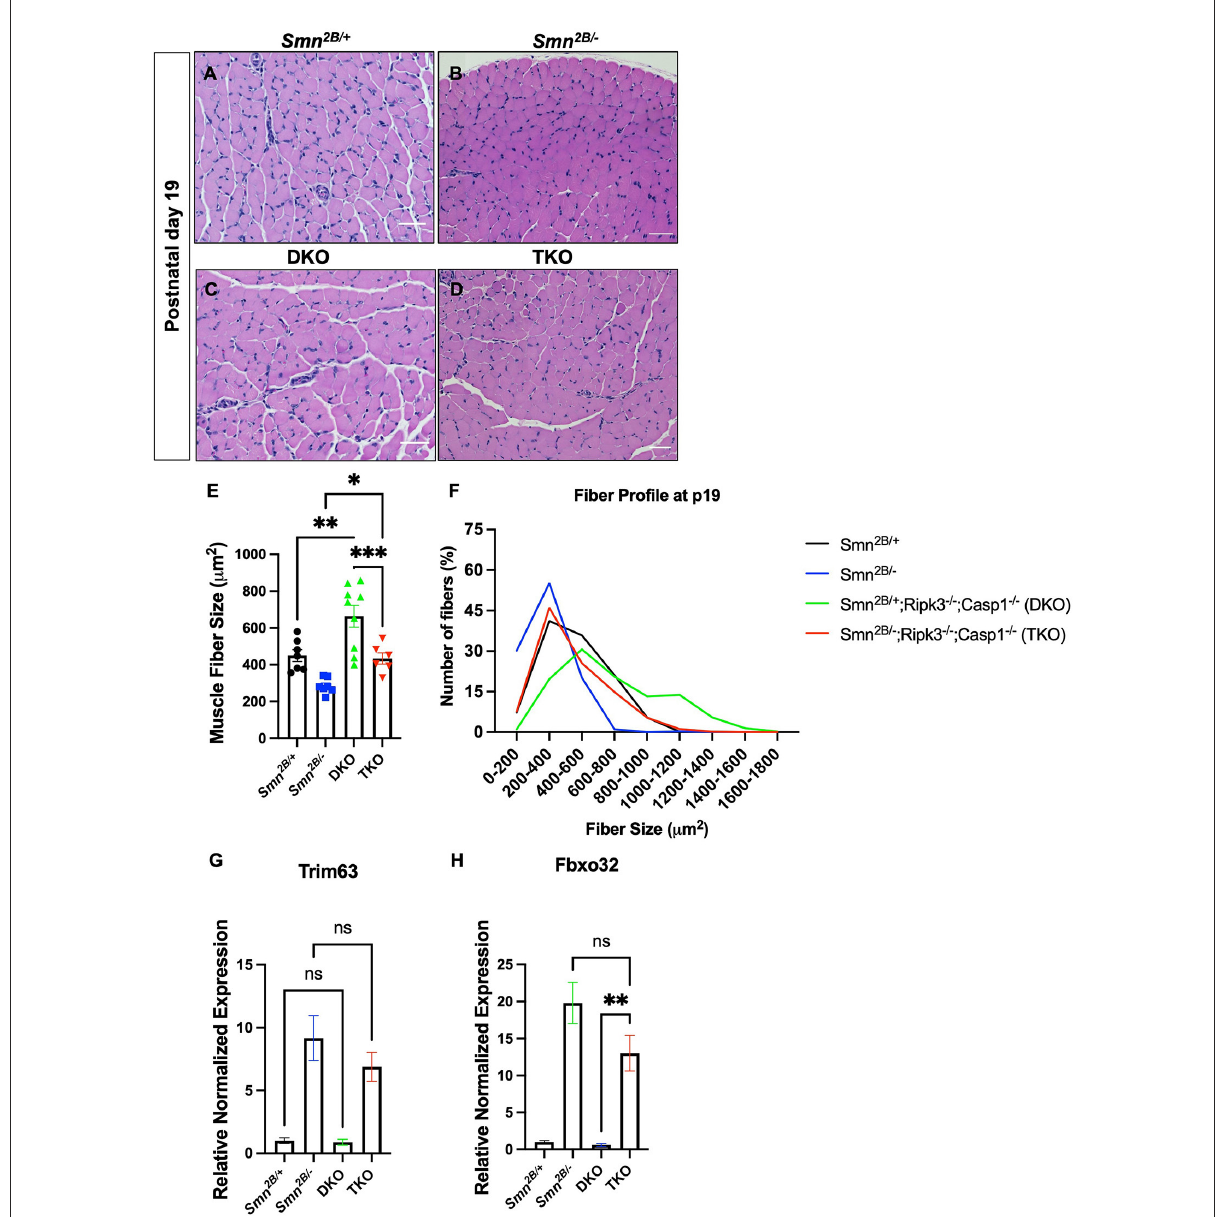
FIGURE6 Genetic ablation of necroptotic cell death pathways increases muscle fiber size in both Smn 2 B / + and Smn 2 B / − mice. (A–D) Representative images of H&E-stained tibialis anterior (TA) muscle from P19 mice and (E) quantification of muscle fiber size area size. The fiber size profile distribution (F) is shifted to the right in the DKO and TKO muscle. Primers targeting Atrogin-1 (Fbxo32), MuRF1 (Trim63), and Gapdh were used to examine whether muscle fiber size was rescued due to reduction of muscle atrophy. (G,H) Levels of Atrogin-1 and MuRF1 mRNA are not significantly changed at symptomatic stage (P19) in the hindlimb of TKO mice compared to Smn 2 B / − . Scale bars = 50 µ m . The n value for each study is as follows; (A–E) η = 6 − 9 per genotype, (G,H) η = 4 per genotype. Data represent mean ± SEM. An ordinary one-way ANOVA with Tukey post-hoc test for multiple comparison. P < 0.05 for * , P < 0.001 for ** , and P < 0.0002 for *** . ns,